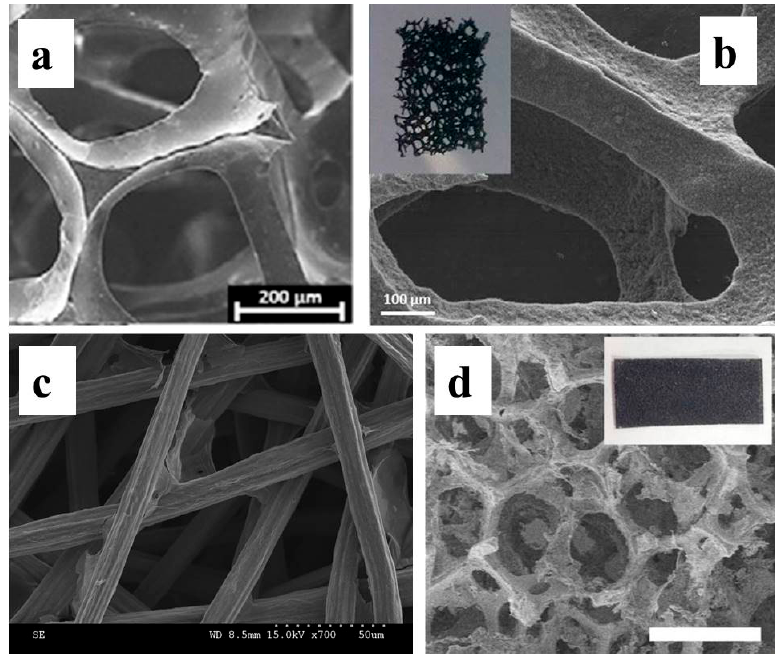
Figure 3. SEM image of ( a ) reticulated carbon foam [83]; ( b ) Carbon Nanoweb modified reticulated vitreous carbon [84]; ( c ) graphene oxide modified stainless steel fiber felt [85]; ( d ) rGO coated nickel foam, the bar is 200 μ m [87]. Reproduced with permission from Elsevier and the Royal Society of Chemistry.